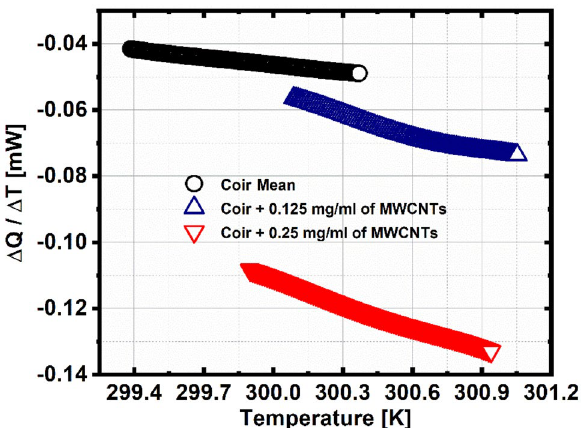
Figure 5. Heat flow as a function of temperature.